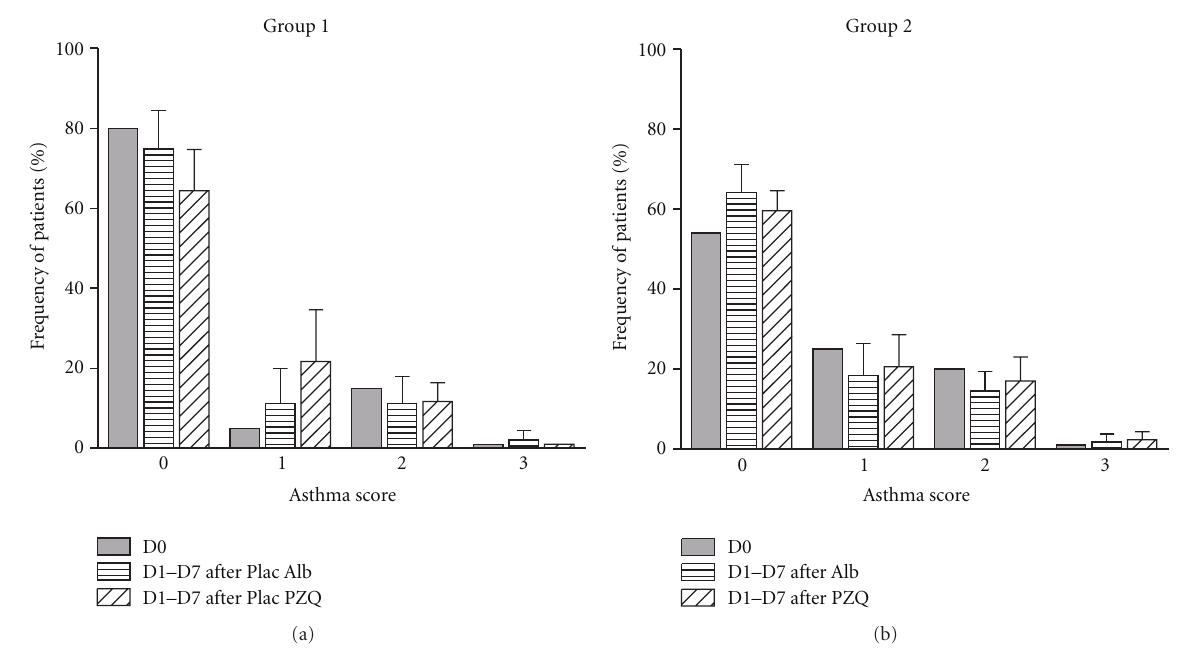
Figure 2: Frequency of clinical scores of asthma in patients from Group 1 at day zero (D0) and one to seven days (D1–D7) after treatment with placebo (Plac) of Albendazole (Alb) and placebo of Praziquantel (PZQ) (a); and at day zero (D0) and one to seven days (D1–D7) after treatment with Albendazole or Praziquantel (Group 2) (b). Praziquantel was given seven days after the treatment with Albendazole in the Group 2. Data were represented as mean ± SD. There was no significant di ff erence in the frequency of asthma scores between D0 versus D1–D7 in none of groups ( P > 0 . 05; Chi-square Test for